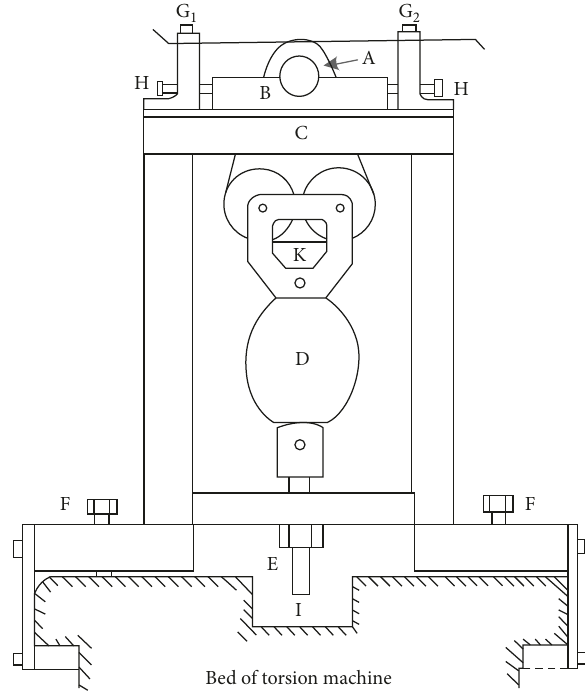
Figure 3: The clamp designed by Campbell and Dowling